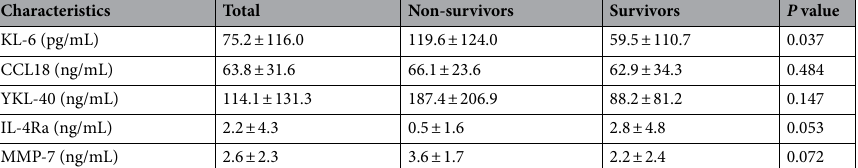
Table 2. Baseline levels of blood biomarkers in non-survivors and survivors for patients with SJS-ILD. Data are presented as mean ± standard deviation or number (%), unless otherwise indicated. CCL18 CC chemokine ligand 18, IL-4Ra interleukin-4 receptor alpha, ILD interstitial lung disease, KL-6 Krebs von den Lungen-6, MMP-7 matrix metalloproteinase-7, SJS Sjögren syndrome, YKL-40 chitinase-3-like-1.